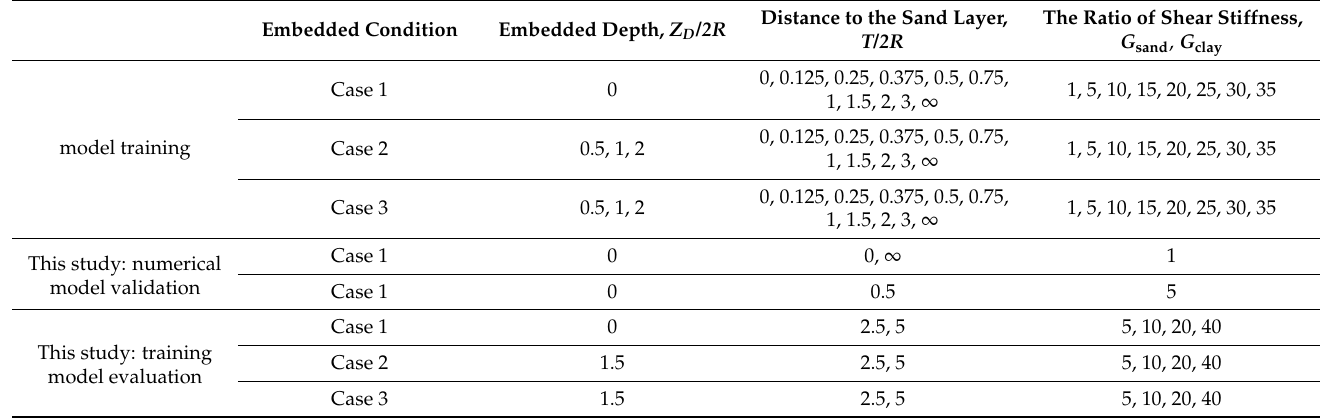
Table 1. The simulation programs in [5] and this study.